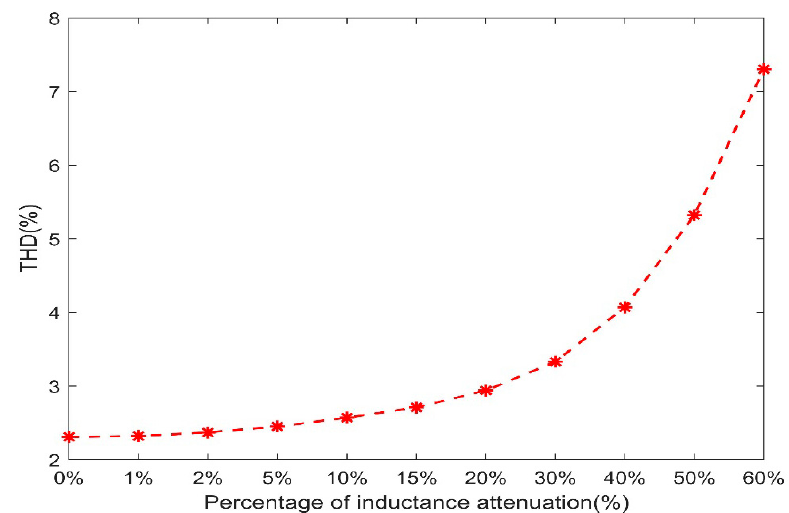
Figure 18. Performance curve of inductance change using ASMCN − FNN.